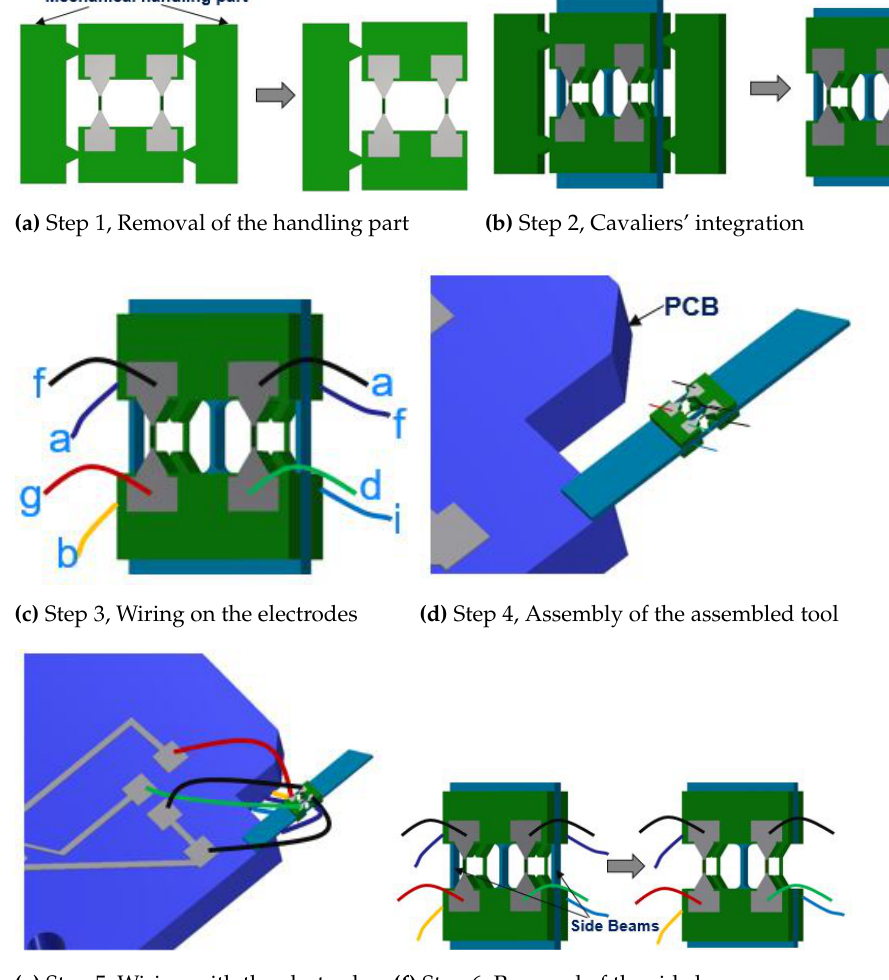
Figure 9. Steps involved in the assembly